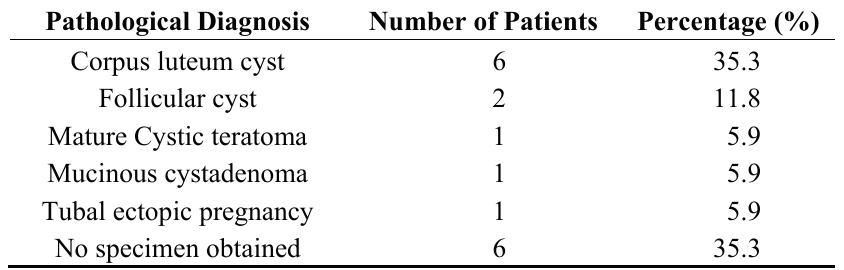
Table 3. Final histopathological diagnosis in patients with adnexial torsion during